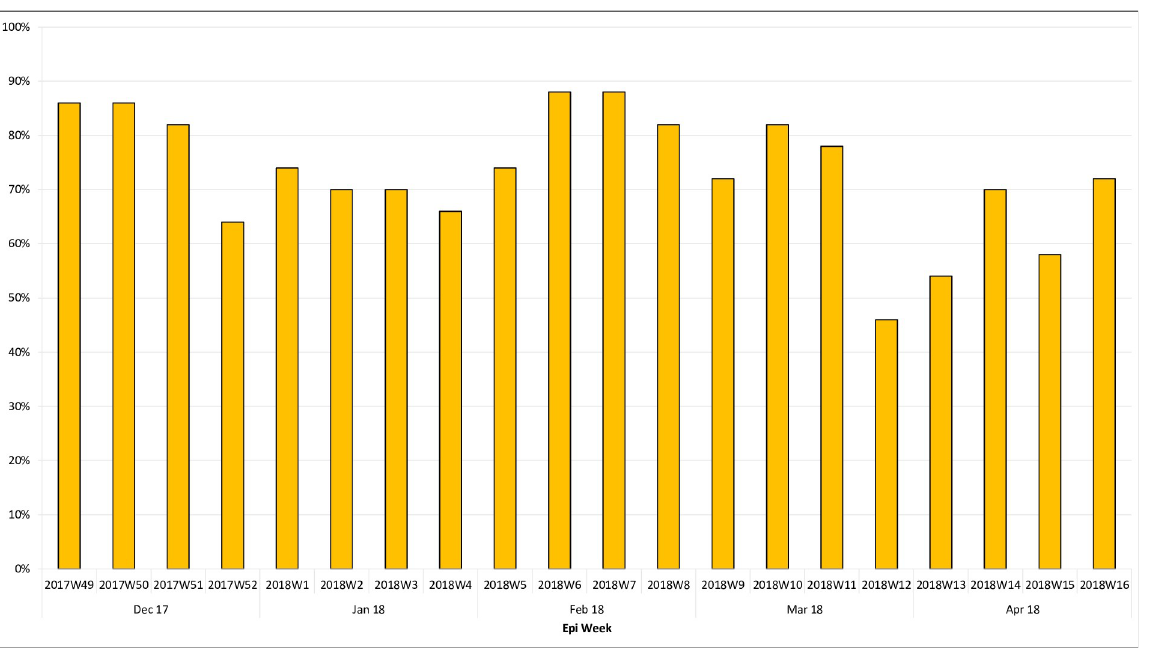
Fig 3. Weekly reporting from HFs on the daily SMS platform, December 2017-April